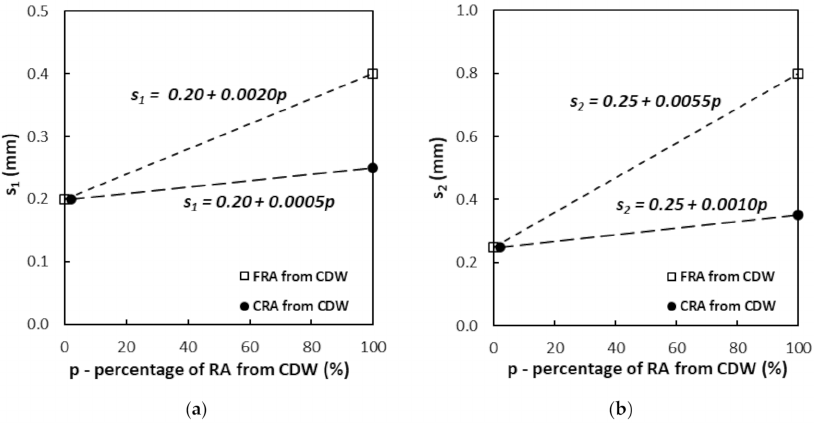
Figure 8. Variation of ( a ) s1 and ( b ) s2 with the percentage of NA replaced with RA from